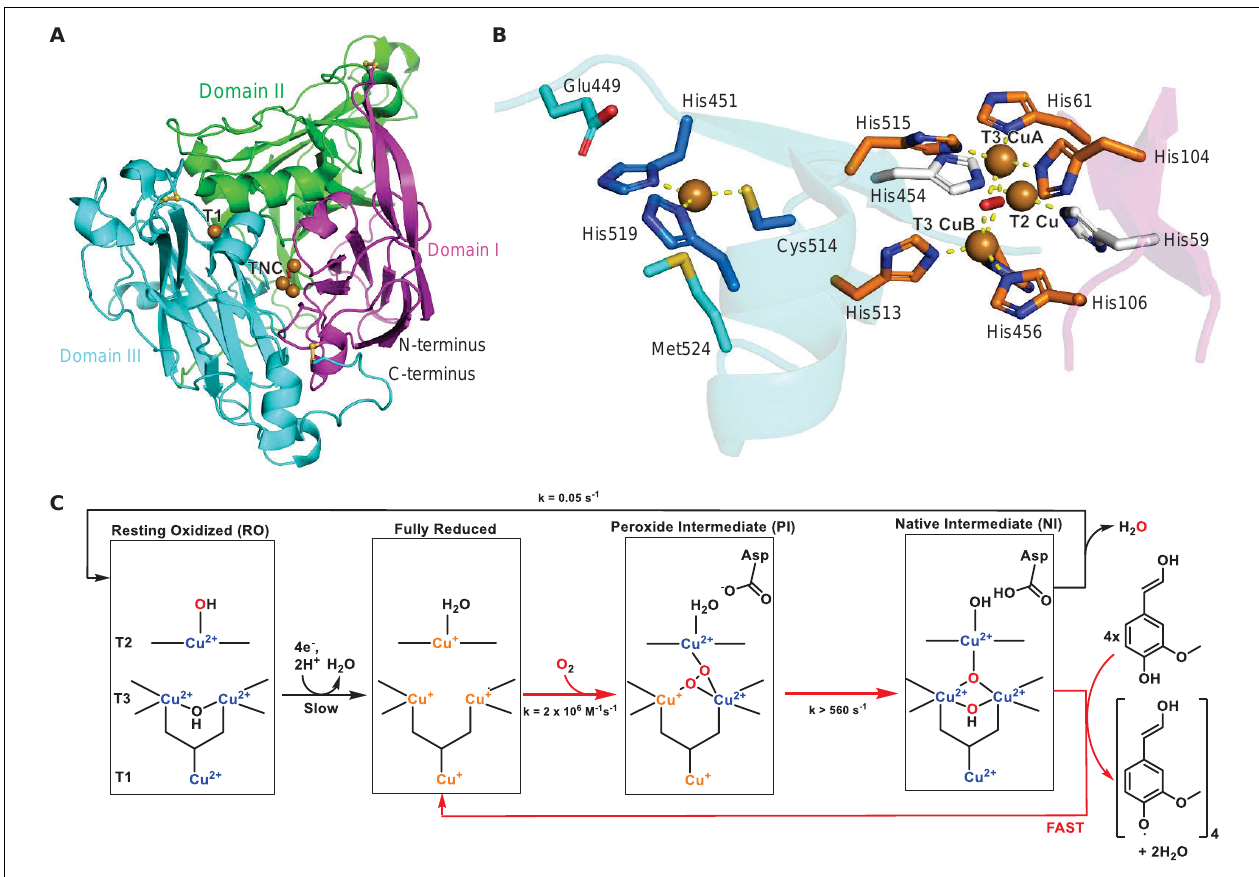
FIGURE 2 | Structure of a plant laccase. (A) Protein structure of maize laccase ZmLac3 (PDB ID: 6KLG) (Xie et al., 2020). The three domains are highlighted in magenta, green and blue, the copper atoms are shown as brown spheres and disulfide bonds as yellow sticks. (B) Copper center of ZmLac3 laccase with T1 and TNC copper atoms and corresponding copper-binding residues. A water or hydroxide molecule is shown as a red sphere. Copper coordination is highlighted by yellow dashed lines. (C) Catalytic mechanism of laccase with catalytic cycle highlighted by red arrows and reduction of resting state (RO) or decay of native intermediate (NI) state to resting state highlighted by black arrows. Adapted with permission from Augustine et al. (2010; Copyright 2010 American Chemical